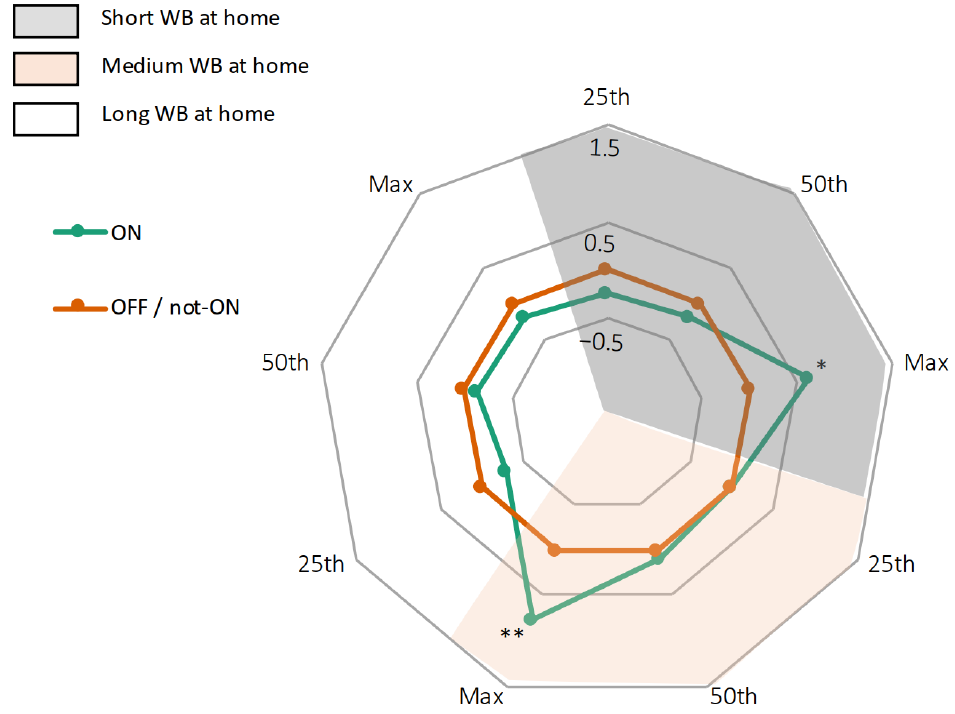
Figure 4. Radar plot illustrating gait speeds of 27 PD patients in their domestic environment, broken down into different WB. Gait speeds during medication not-ON are set at 0 (orange line), gait speeds during medication ON are presented as deviation from 0 (green line). * p < 0.05, ** p < 0.01.